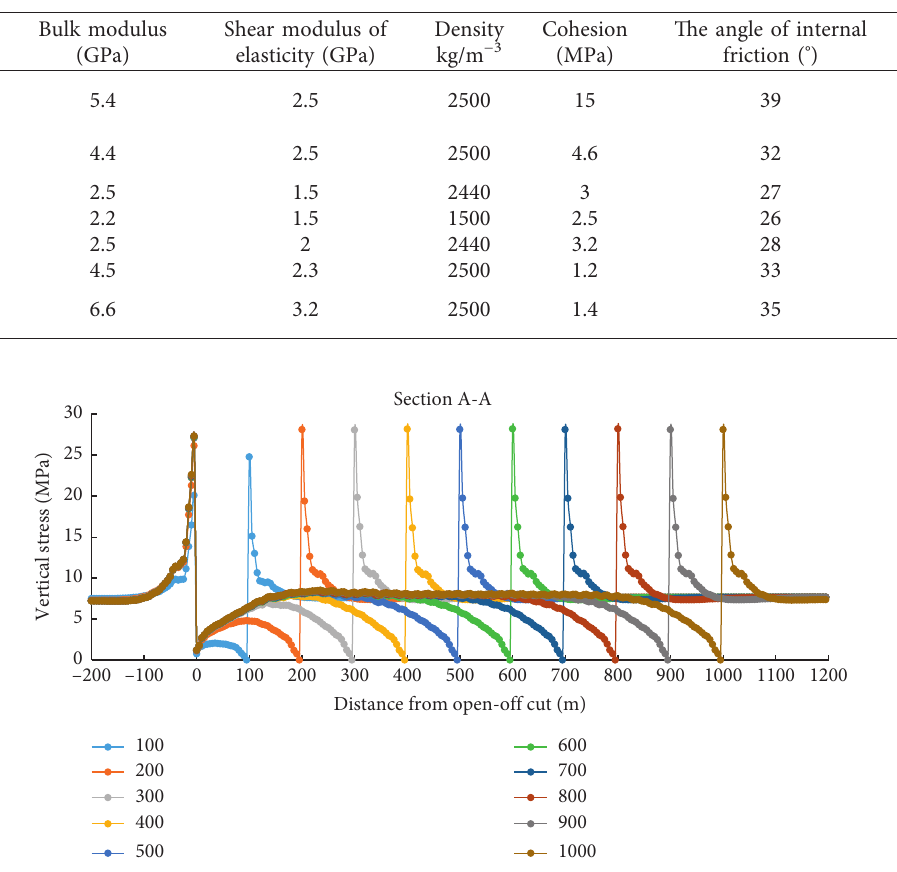
Figure 6: Vertical stress distribution along the goaf in the middle of the coal-mining